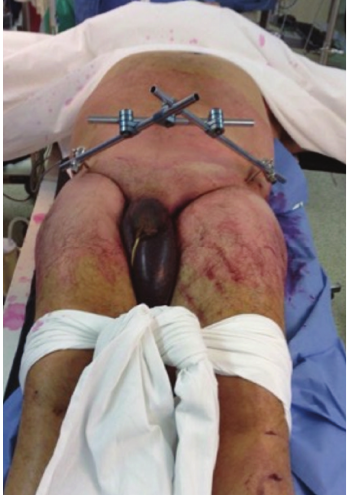
Figure 1: Clinical photograph showing skin marks of truck wheels on the left thigh, extensive scrotal hematoma, and swelling.